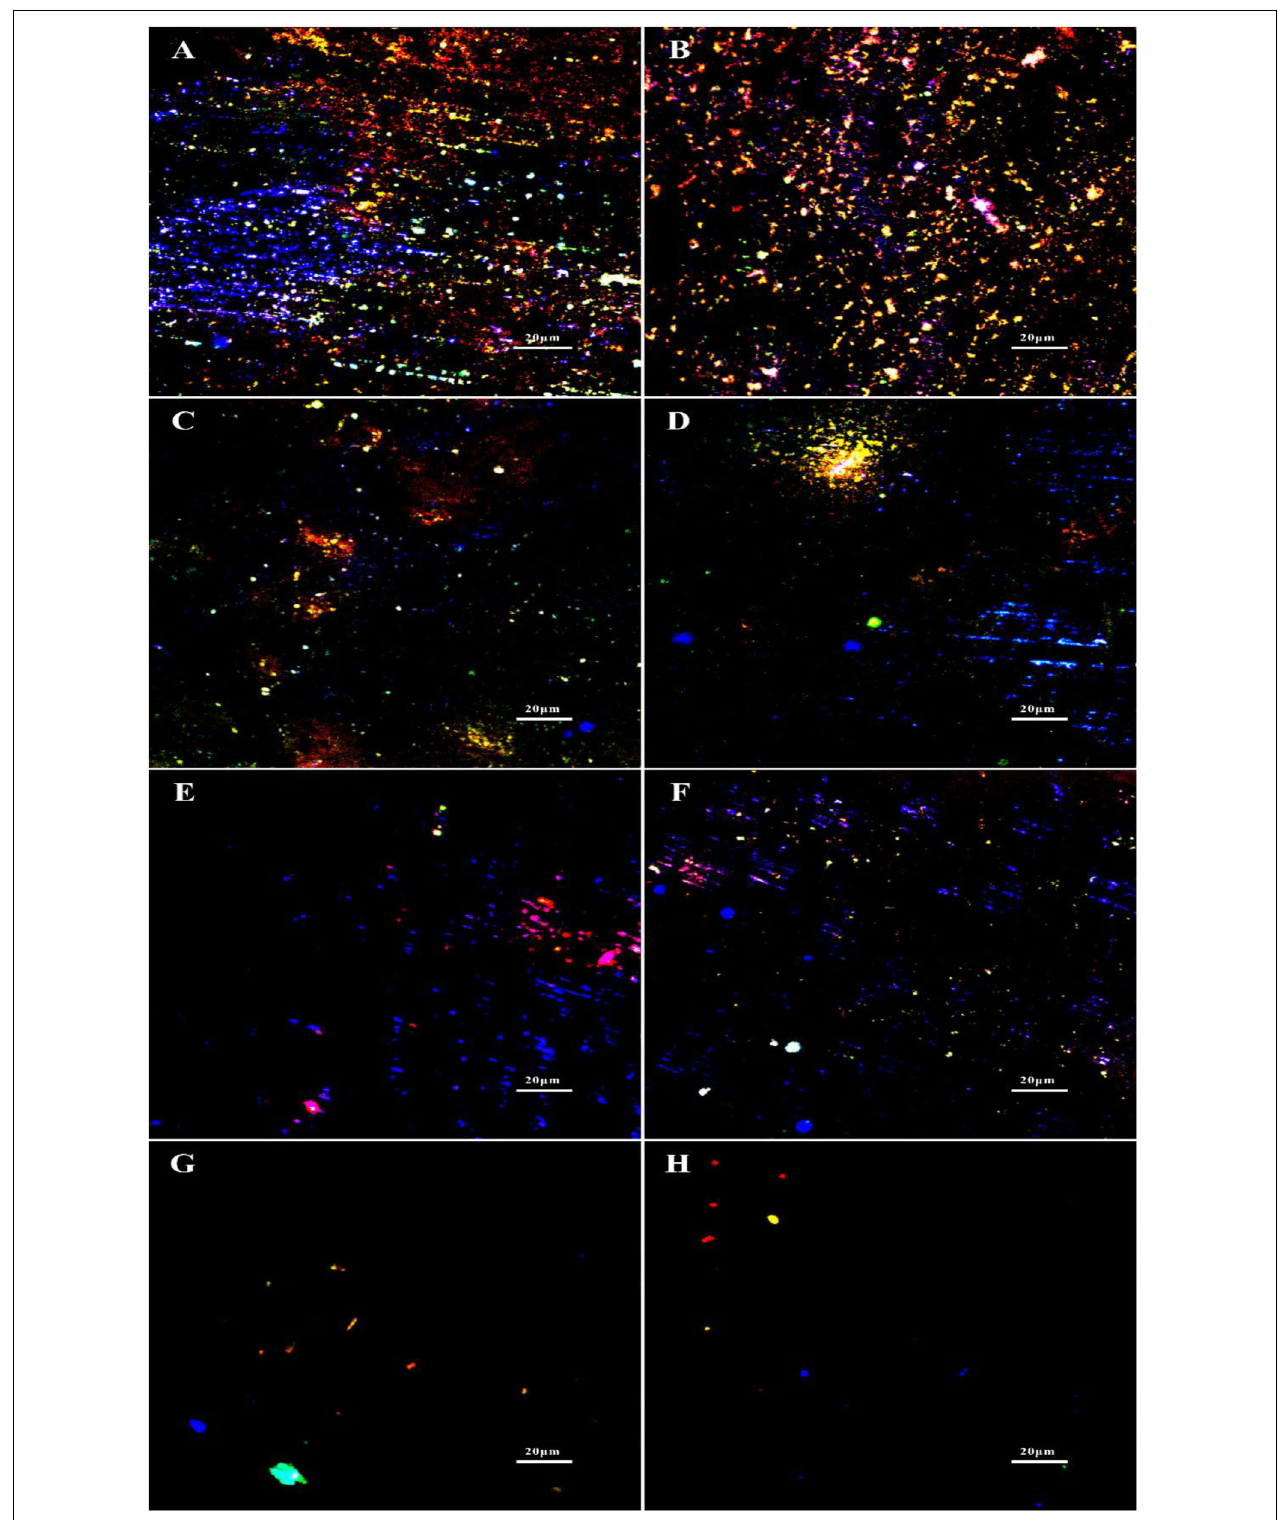
FIGURE 11 | EPS staining after 1-day biofilm removal test: (A) no treatment (control), (B) 1 ppm D -Tyr, (C) 100 ppm D -Met, (D) 5 ppm CMIT/MIT, (E) 5 ppm CMIT/MIT + 1 ppm D -Tyr, (F) 5 ppm CMIT/MIT + 100 ppm D -Met, (G) 5 ppm CMIT/MIT + 1 ppm D -Tyr + 100 ppm D -Met, and (H) 25 ppm CMIT/MIT. Blue, red, and green dots represent extracellular DNAs, proteins, and polysaccharides, respectively.